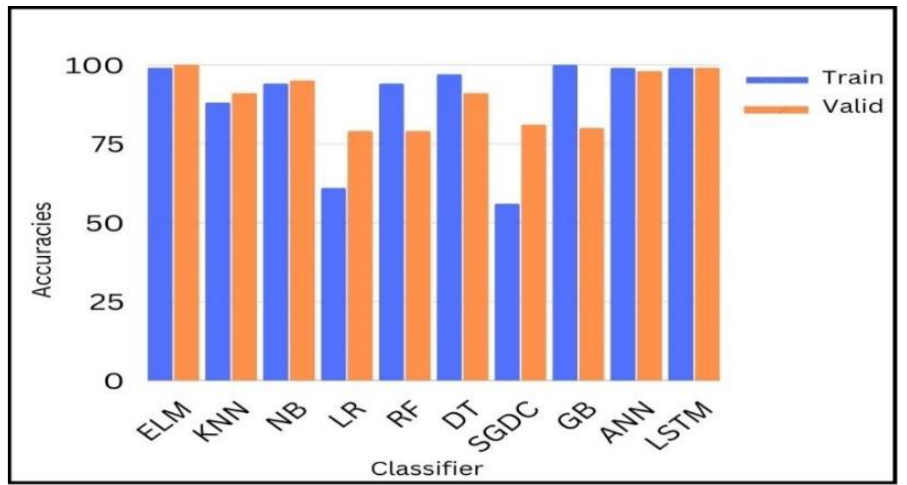
Figure 12. Training and Testing Accuracies of ML and DL Models.